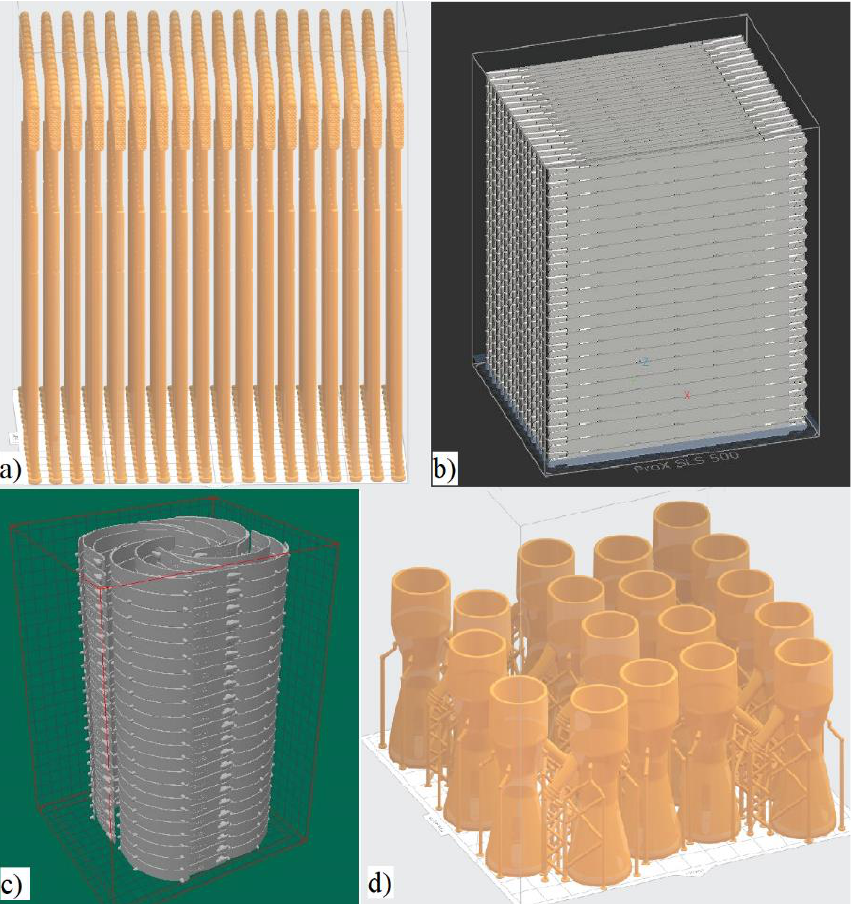
Figure 1. Packing solutions of parts in different build volumes: ( a ) nasal swab in Form 2; ( b ) face shield holder SLS optimized in ProX SLS 500; ( c ) face shield holder in ProX SLS 500; and ( d ) Venturi valve in Form 2.